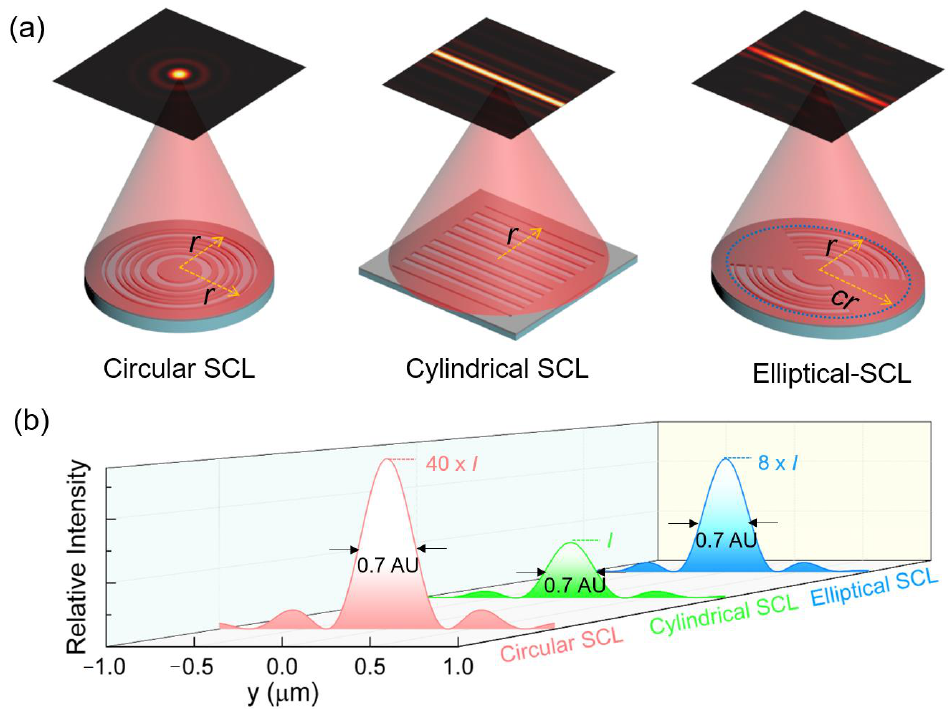
Figure 5. Comparison of three different types of supercritical lens. ( a ) Schematic diagram of sub- diffraction-limited focusing of different planar diffractive lenses, including a conventional circular supercritical lens, a 1D grating-type cylindrical supercritical lens, and an elliptical supercritical lens; ( b ) the relative intensity of the focal spot created by the circular SCL and transverse needles created by the cylindrical SCL and elliptical SCL. AU stand for Airy units; that is the radius of the Airy spot in the diffraction limited optical system. The transverse optical needle created by the elliptical SCL is shorter than the cylindrical SCL, but with eight times higher field intensity in the needle